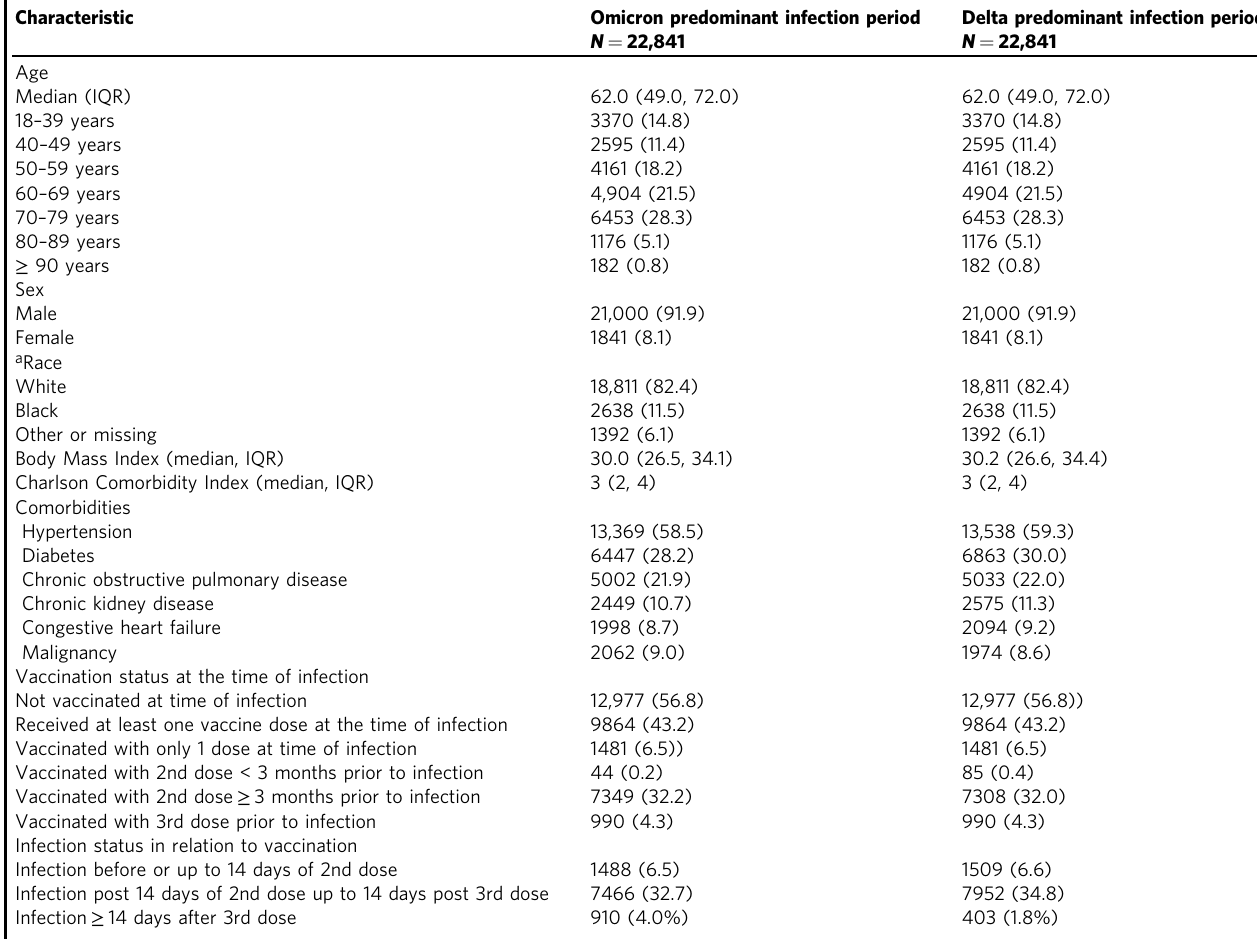
Table 1 Baseline characteristics of propensity score-matched veterans infected during Omicron and Delta predominant periods.